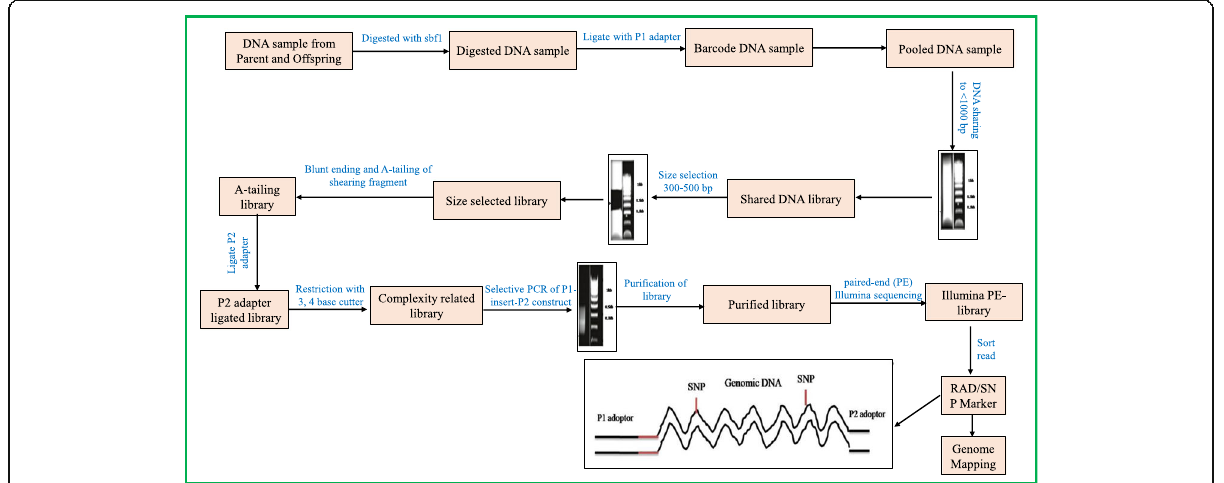
Fig. 2 RAD-sequence: discovery and genotyping of SNPs by next-generation sequencing for genome mapping.EcoRI-MspI ligation as “ adapter_P1-EcoRI ” and “ adapter_P2-MspI